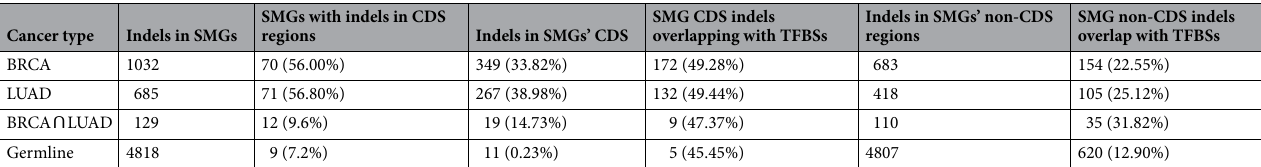
Table 6. Somatic transcript indels in 125 SMGs of BRCA and